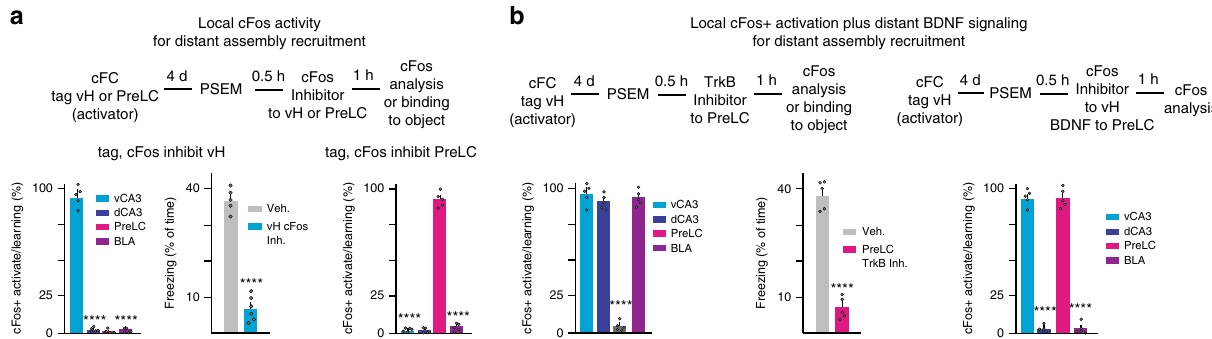
Fig. 6 Distant assembly recruitment involving local cFos activity and distant BDNF signaling. a Local re-activation of tagged cFos + neurons, combined with local inhibition of cFos activity prevents network-wide recruitment of cFos + neurons without affecting local recruitment; values as described in Fig. 5c (local vH: one-way ANOVA, P < 0.0001, n = 5 each; local PreLC: one-way ANOVA, P < 0.0001, n = 5 each). Center: absence of network-wide cFos recruitment prevents time unit function (unpaired t -test, t (9) = 10.17, P < 0.0001, n = 5,6). b Role of BDNF signaling for distant cFos + neuron recruitment. Left: local re-activation of tagged cFos + neurons in vH, combined with local delivery of TrkB inhibitor to PreLC speci fi cally prevents induction of cFos expression in PreLC; values as described for Fig. 5c (one-way ANOVA, P < 0.0001, n = 5 each) and time unit function (unpaired t -test, t (8) = 8.525, P < 0.0001, n = 5 each). Right: local delivery of BDNF to PreLC is suf fi cient to disinhibit cFos induction upon local re-activation of tagged vH cFos + neurons, combined with local inhibition of cFos activity in vH (one-way ANOVA, P < 0.0001, n = 5 each). Error bars: SEM; P < 0.05 (*), 0.01 (**), 0.001 (***), 0.0001 (****). For a more detailed description of the statistical analysis please refer to Supplementary Table 6